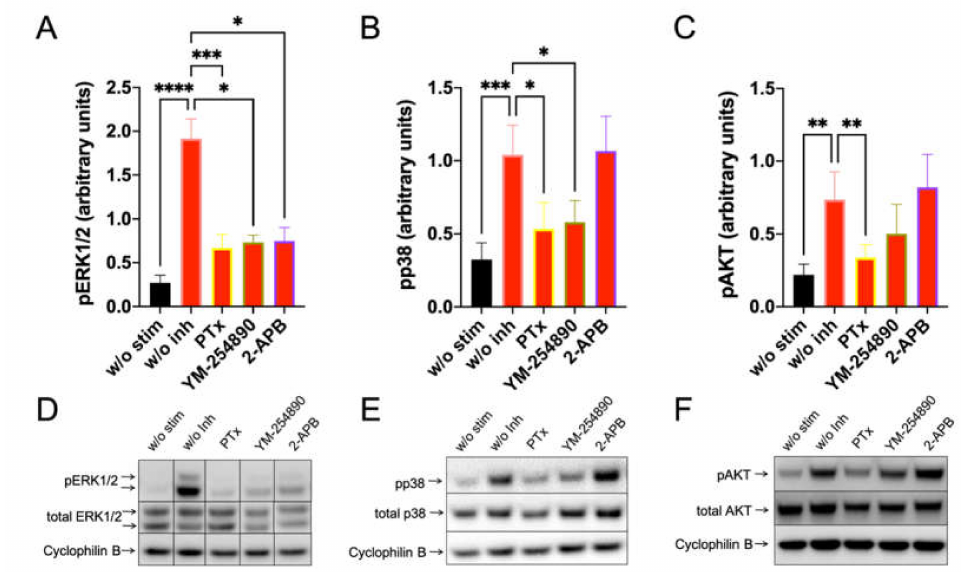
Figure 3. C48/80 activated pERK depends on G α i , G α q , and Ca++, while pAKT exclusively requires the action of G α i only. Cultured skin-derived MCs were pretreated with PTX (200 ng/mL), YM-254890 (10 µ M), 2-APB (100 µ M), or no inhibitor (w/o Inh) then stimulated with c48/80 (10 µ g/mL) for 1 min. Cells receiving no inhibitor or stimulus were the negative control (w/o stim). ( A – C ) Phosphorylation signals detected consecutively on the same membranes for ERK1/2, p38 and AKT, quantified and normalized to cyclophilin B as described in methods. Mean ± SEM of 10–15 independent experiments (individual cultures). * p < 0.05, ** p < 0.01, *** p < 0.001, **** p < 0.0001. ( D – F ) Representative blots of